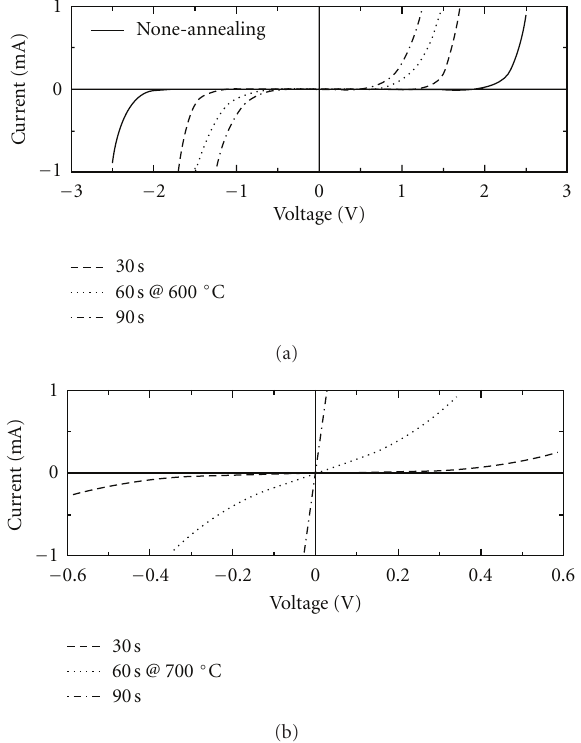
Figure 6: Measured currents of MSM diode as a function of applied voltage for noneannealing and